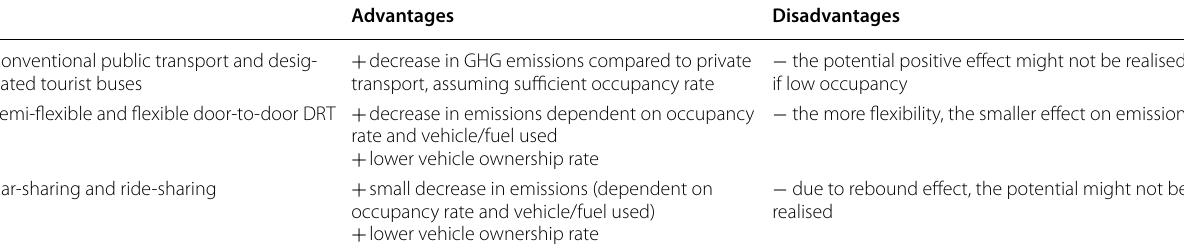
Composed based on Mullay and Nelson [78], Firnkorn and Müller [85], Ryley et al. [65], Reichert et al. [81], Ferrero et al. [25], Amatuni et al. [79], Coutinho et al. [83], Jochem et al. [26] and TNMT